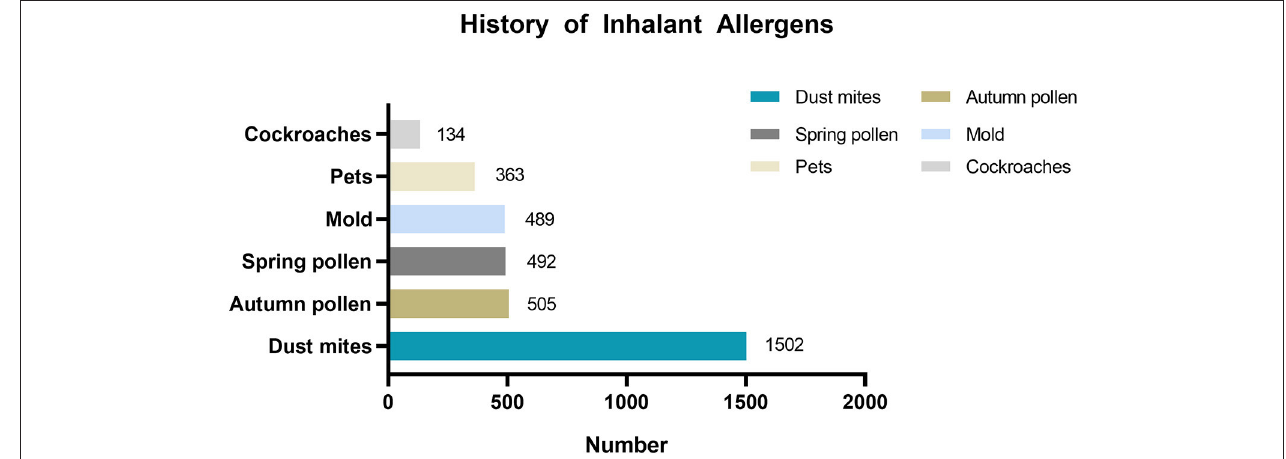
FIGURE 2 | History of inhalant allergens sensitization distribution in patients with asthma trigger of allergen sensitization.